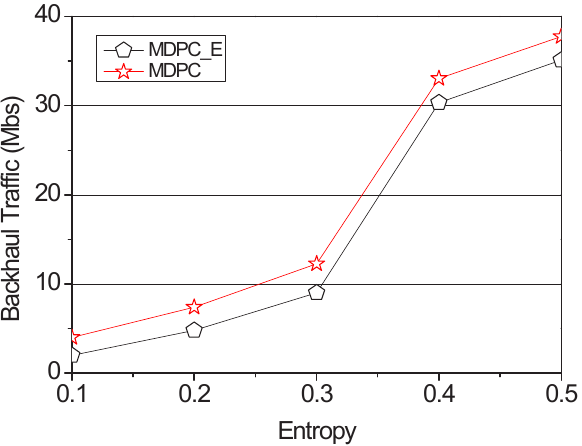
Figure 13 shows a graph of the delay time measured with the entropy value from 0.1 to 1.6. When the entropy value is 0.6, MDPC and MDPC_E backhaul traffic is almost the same. When the entropy value is 0.6, the backhaul traffic of MDPC and MDPC_E becomes almost the same. However, when the entropy value is 0.6 or more, the accuracy of the probability is reduced, and the possibility of the vehicle visiting the RSU having the highest probability is reduced. Therefore, if the entropy is 0.6 or higher, the backhaul traffic of MDPC is higher than the backhaul traffic of